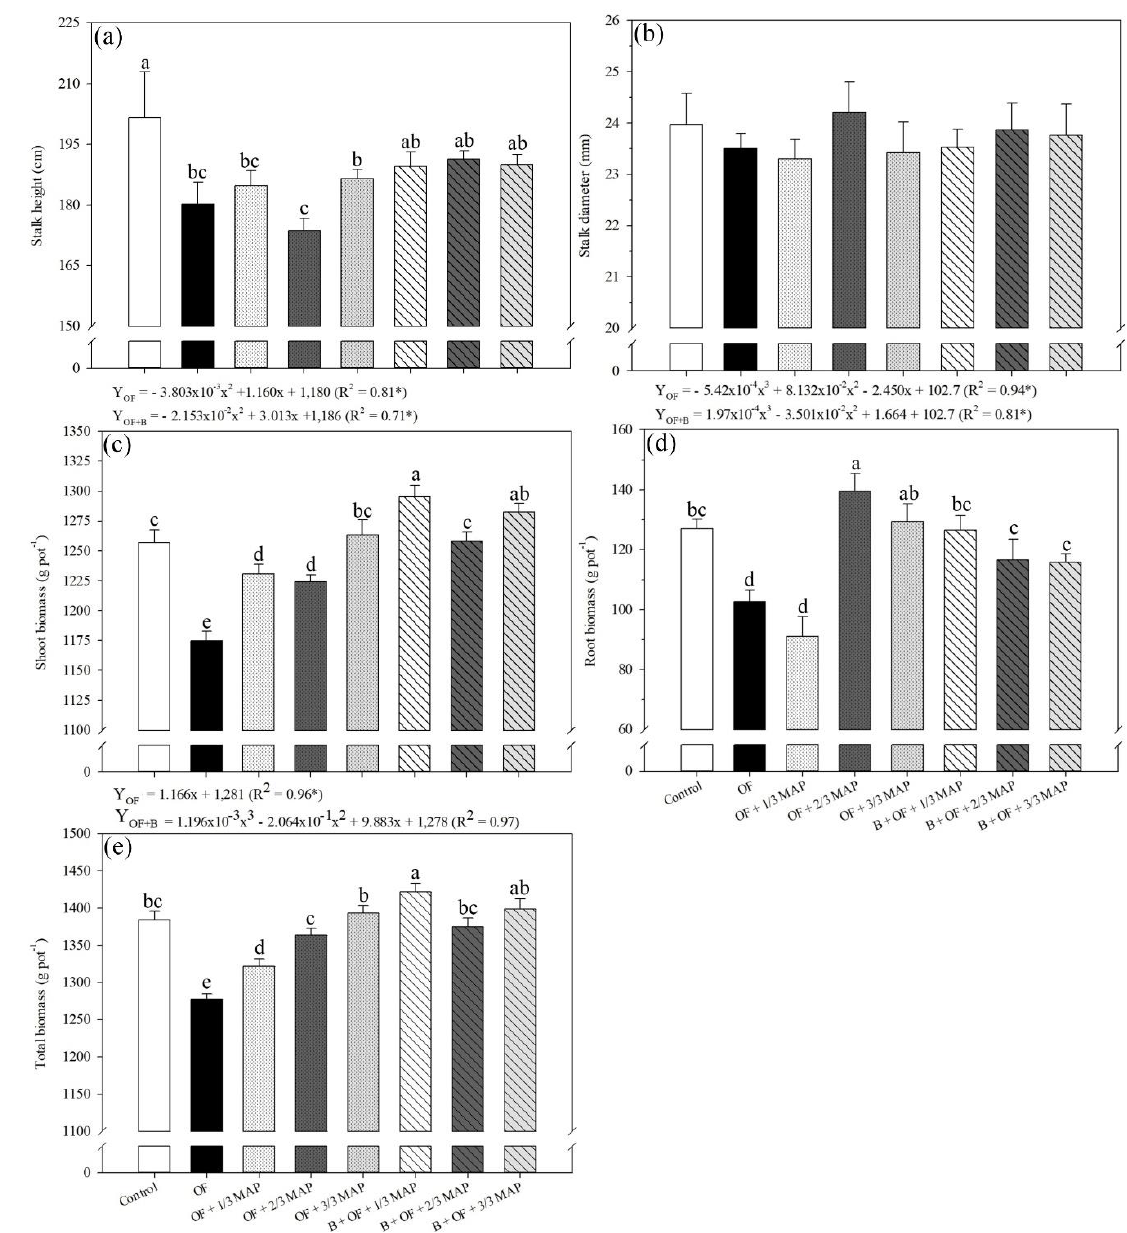
Figure 7. Stalk height ( a ), stalk diameter ( b ), shoot biomass ( c ), root biomass ( d ), and total biomass ( e ) of sugarcane under the association of organomineral fertilizer (OF), B. velezensis (B), and doses of mono ammonium phosphate (MAP). Means followed by the same letter do not differ from each other by the Tukey test at 5% probability. The error bars express the standard deviation of the mean (n = 4). The regression equations and R 2 above the figures include the MAP doses associated with organomineral fertilizer (OF) and with organomineral fertilizer + B. velezensis (OF + B) at the 5% significance level